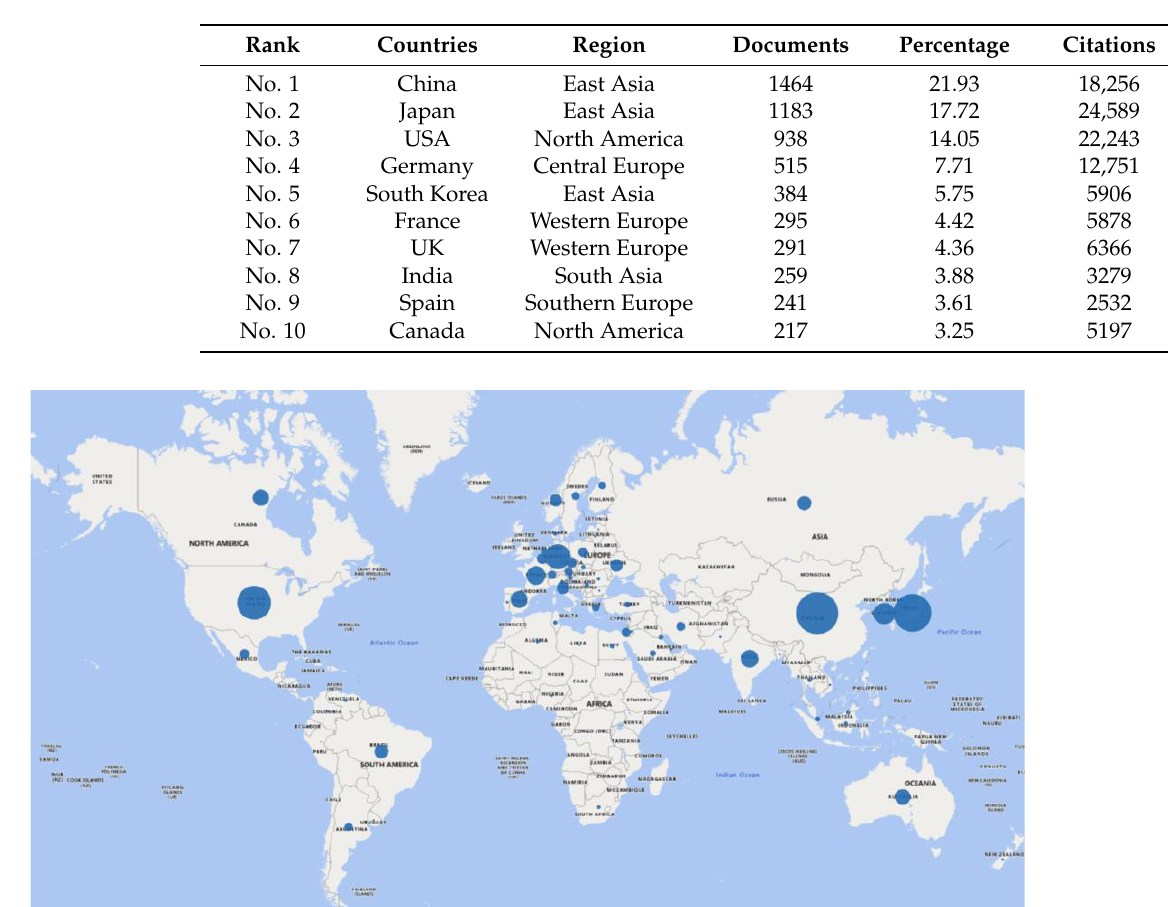
Figure 2. Bubble chart of the number of hydrogen embrittlement publications distributed by coun- try. Table 2. Top ten countries for the number of publications related to hydrogen embrittlement from 1997~2022.